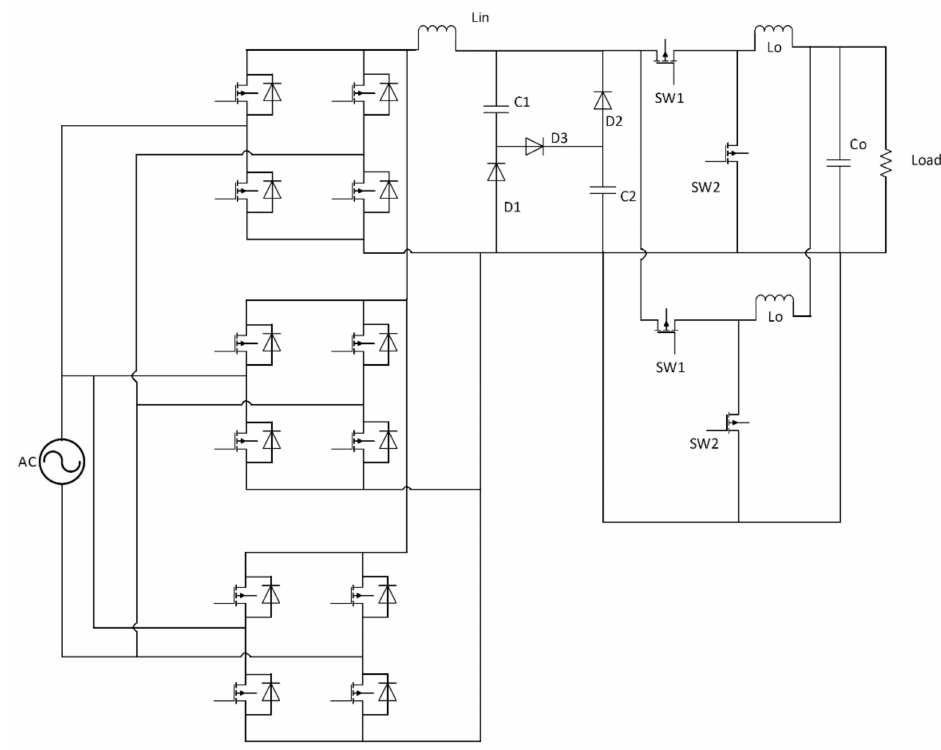
Figure 12. Multicell PSU circuit proposed.